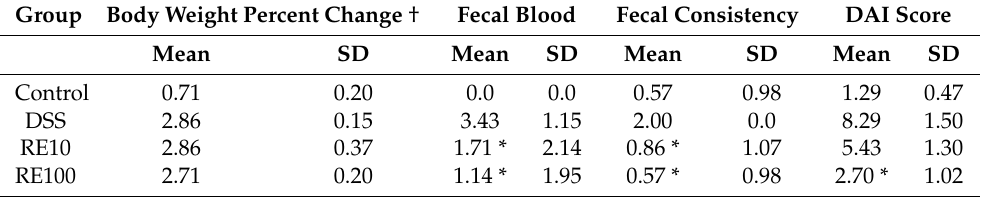
† Body weight percent change is calculated on the basis of the final weight of the mouse compared to the weight on day 0.